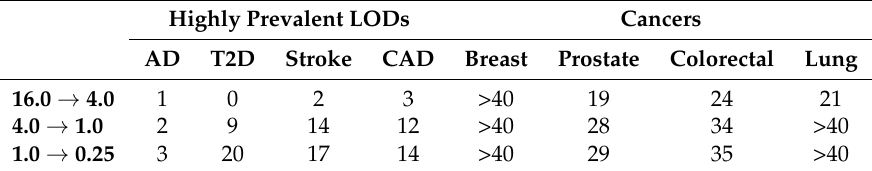
Table 3. Estimate of LOD onset delay for lifetime risk (values in